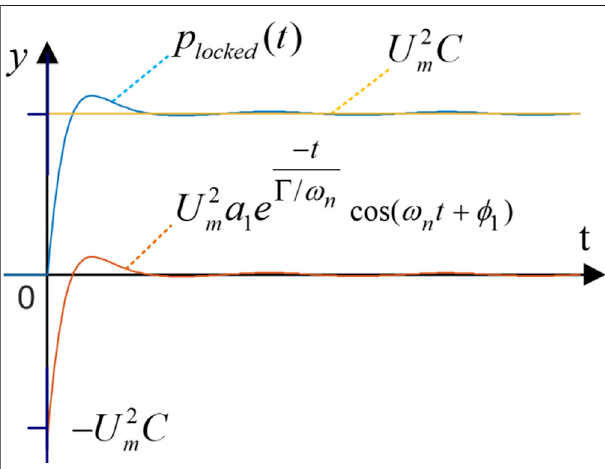
FIGURE 3 | p locked ( t ) and its components (DC,